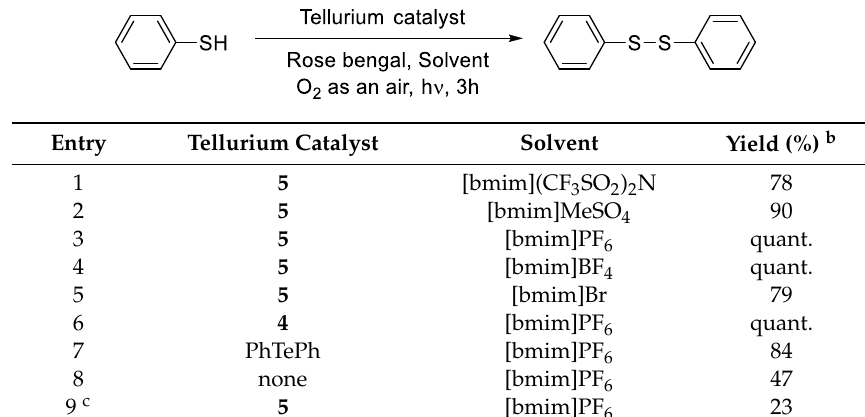
Table 1. Oxidation of thiophenol in the presence of organotellurium catalysts a .